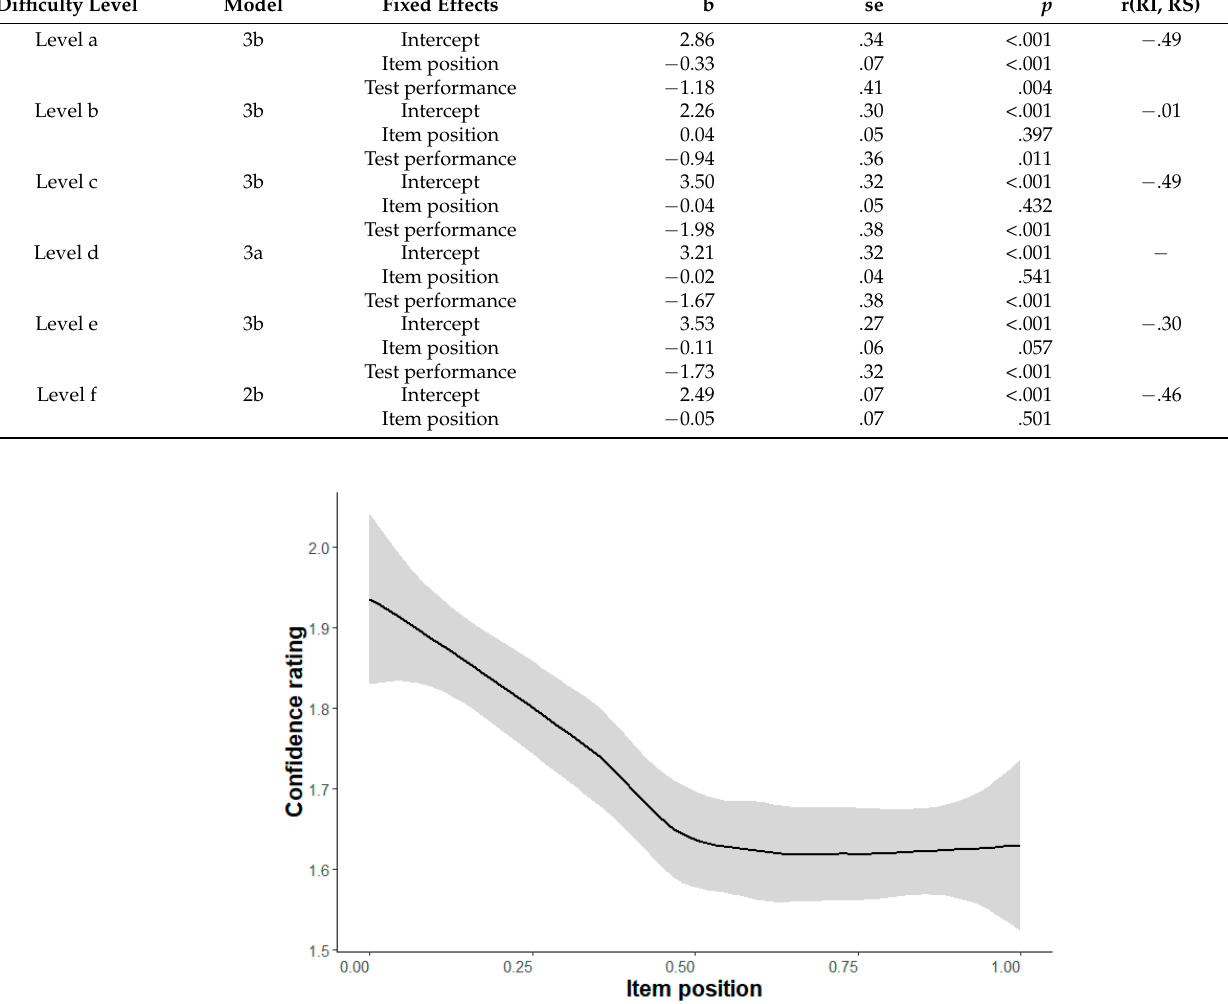
Figure 4. Changes of the confidence rating depending on item position with .95-confidence-interval for Level a.